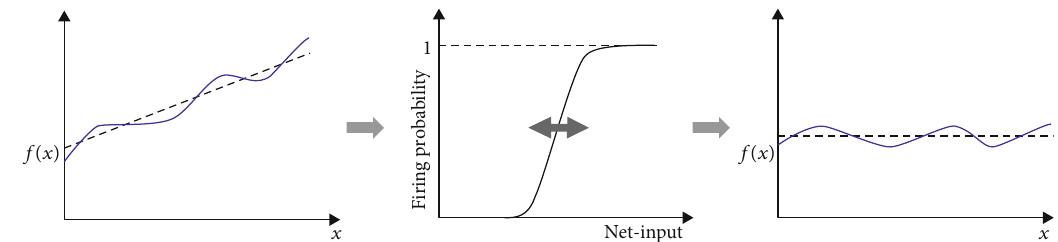
Figure 13: When a time series f ð x Þ is placed at the single input of a neuron with intrinsic plasticity property, the output of the neuron is the same time series f ð x Þ but with its moving average